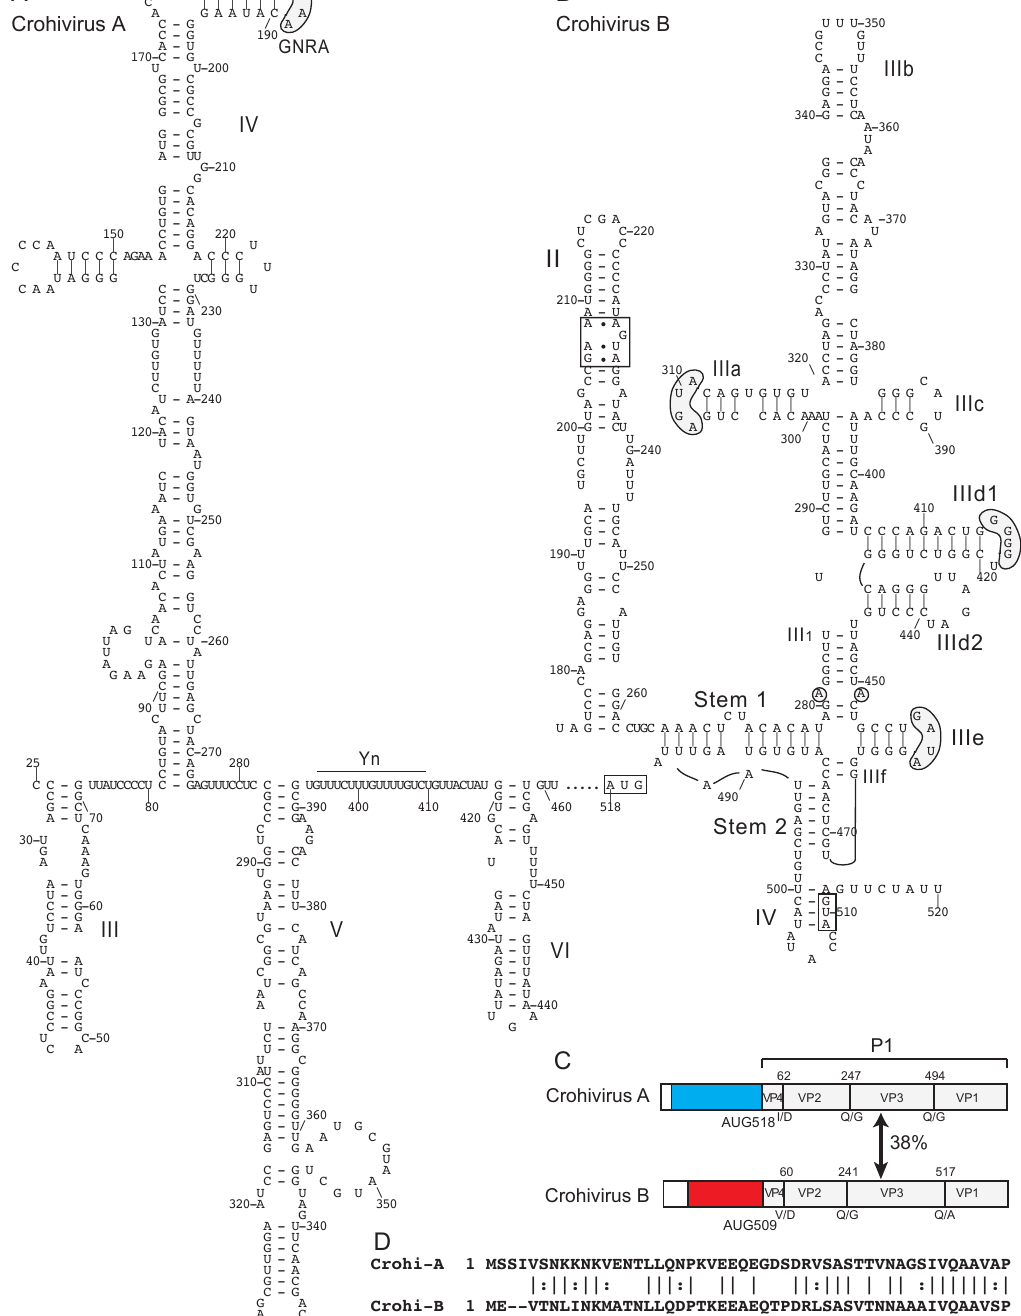
Figure 1. Two di ff erent classes of IRES in the genomes of members of the genus Crohivirus of Picornaviridae . ( A ) Model of the structure of the type I IRES of crohivirus A strain ZM54 (NCBI ref. seq. NC_025474.1) and ( B ) Model of the structure of the type IV IRES of crohivirus B clone Bat / CAM / CroV-P25 / 2013 (NCBI ref. seq. NC_033819.1). Nucleotides are numbered and the initiation codon is boxed. Domains are labeled (A) III – VI and (B) II – IV. The IRES structures have been annotated (A) to show the GNRA tetraloop at the apex of domain IV and the pyrimidine (Yn) tract of the Yn-Xm-AUG motif and (B) to show the loop-E motif in domain II and to highlight sequence